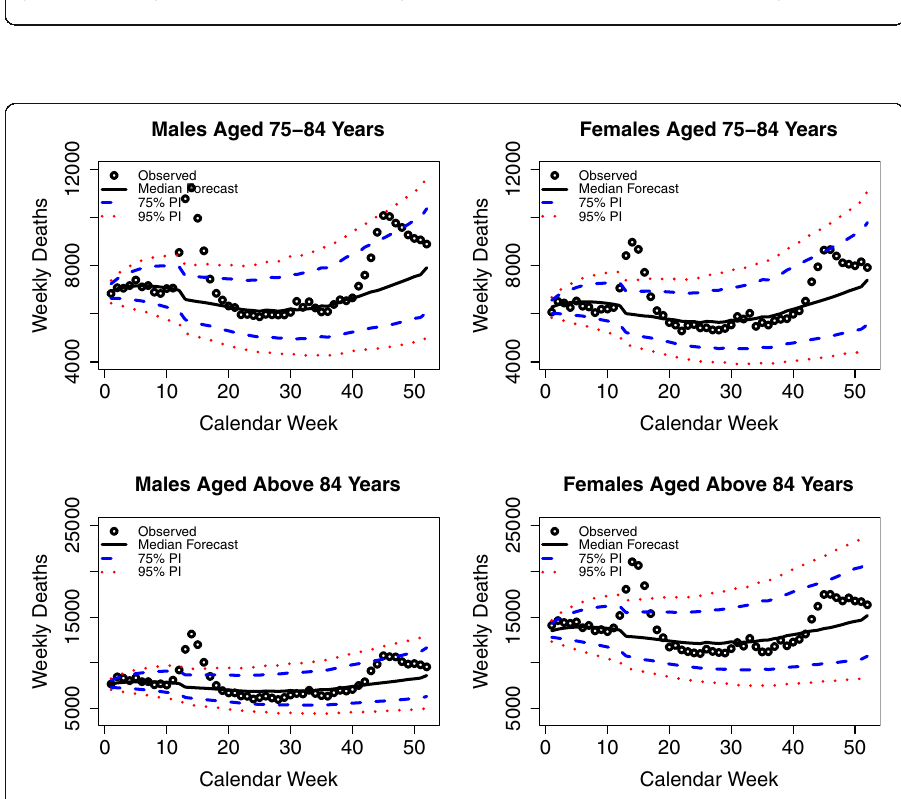
Fig. 14 Observed and predicted weekly sex-specific deaths in 2020 for the 19 study countries and by age group below 75 years, Sources: Human Mortality Database (2021); Own computation and design